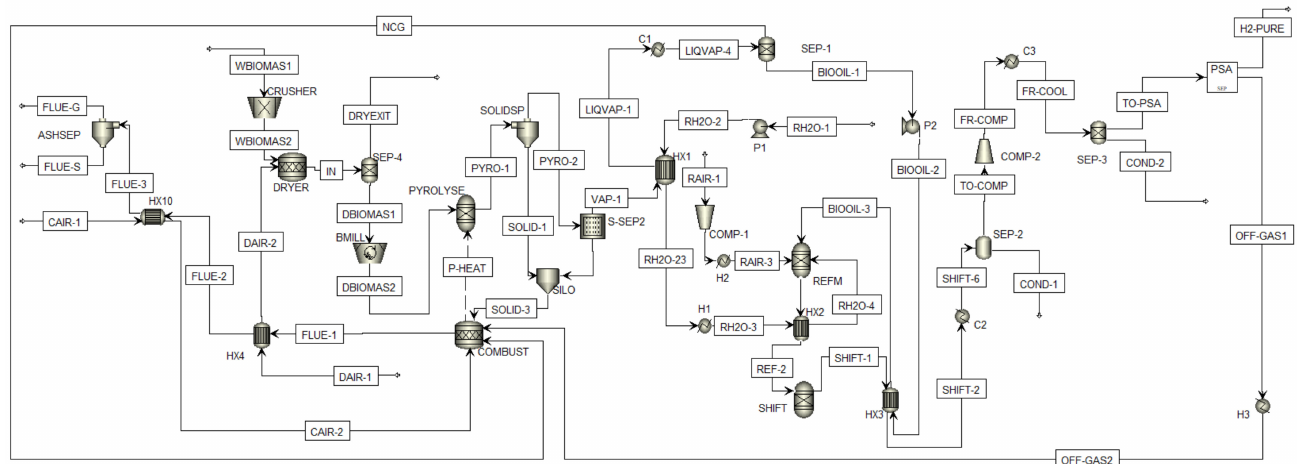
Figure 2. Aspen Plus process flow diagram showing pre-processing, pyrolysis, ATR and hydrogen purification by PSA (PAPS